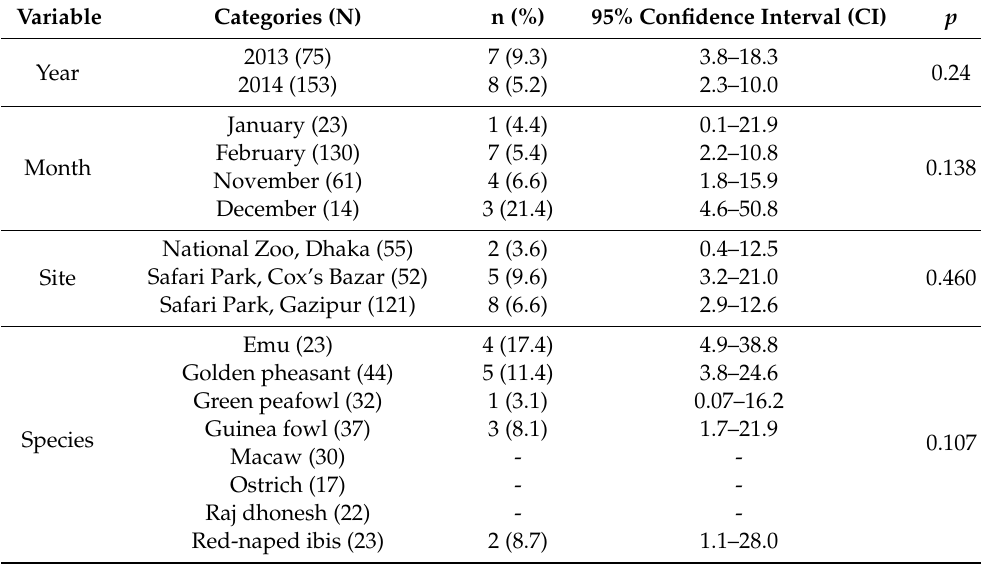
Table 2. Univariate association between di ff erent factors and AIV HA subtype H9 (n =